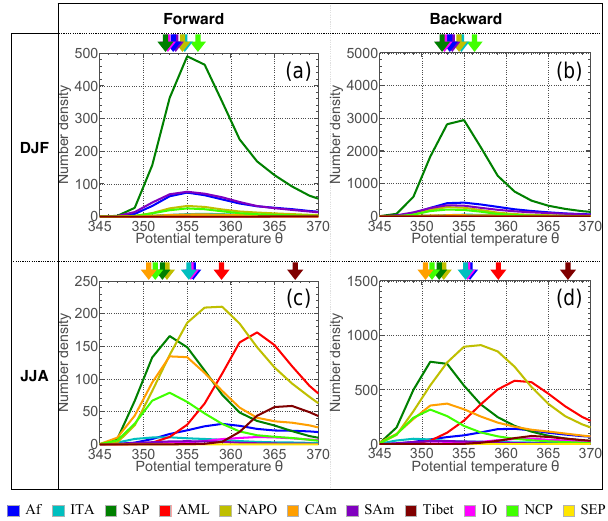
Figure 3. Vertical source distribution of the parcels in boreal win- ter (DJF) and boreal summer (JJA) for forward and backward cal- culations as a function of potential temperature of the source. The vertical axis counts the number of parcels calculated as daily av- erages summing events at the eight CLAUS sampling times (then averaged over DJF and JJA and over 2005–2008) and are given in K − 1 day − 1 . Curves are plotted for each region, with the color code of Fig. 1. The arrows on the upper axes indicate the corresponding mean LZRH levels over the season and